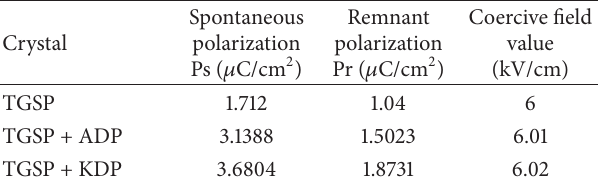
Table 5: Ferroelectric hysteresis loop measurement